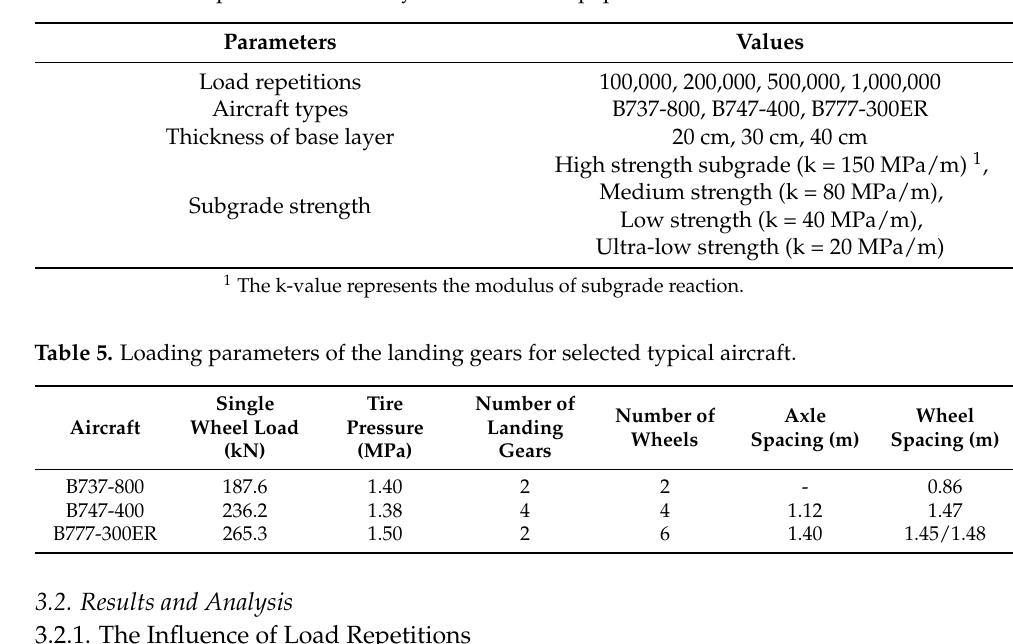
Table 4. Variation parameters of analyzed cases in this paper.